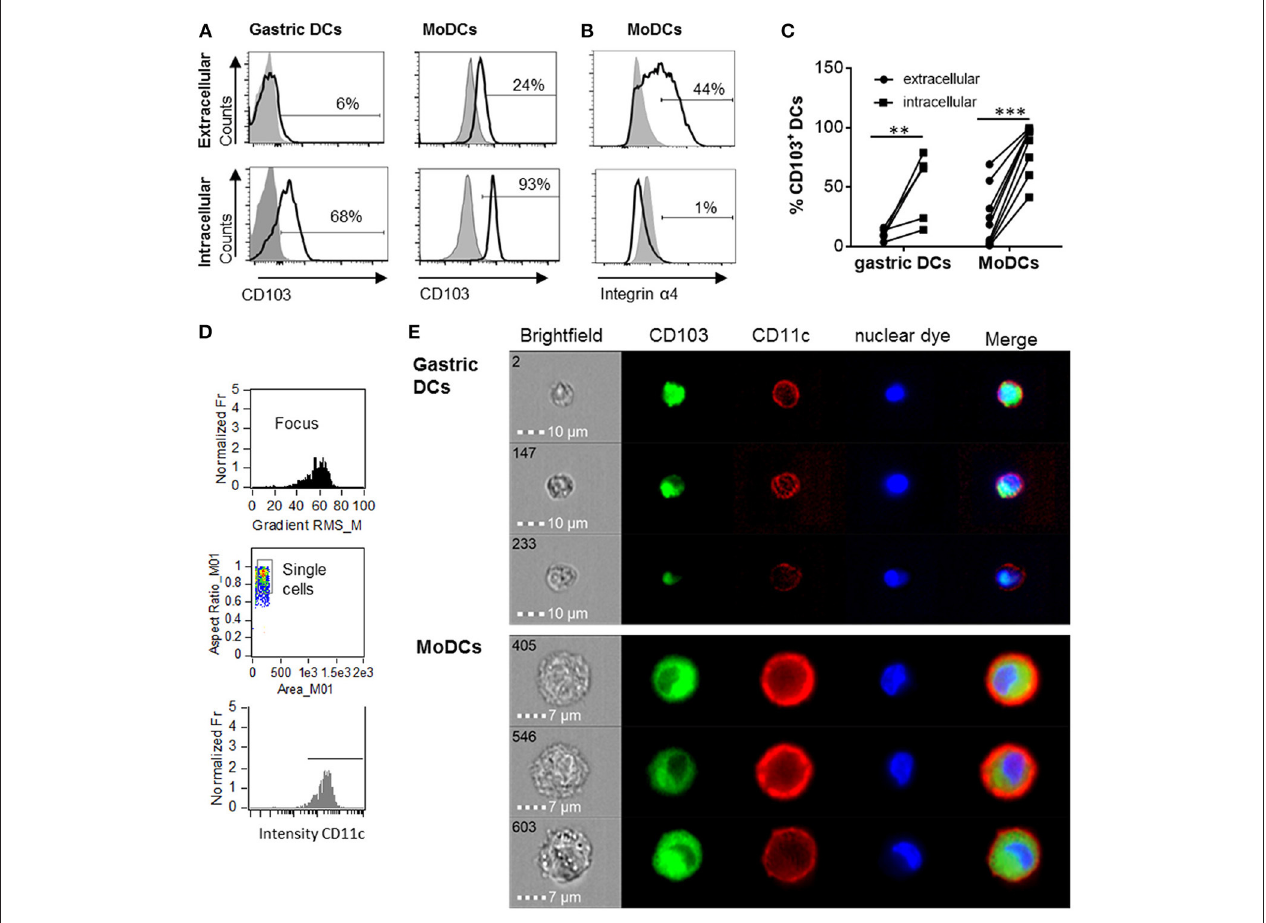
FIGURE 2 | Human gastric and MoDCs contain intracellular CD103 pools. Human gastric DCs gated as live/HLA-DR high /CD45 pos /lineage neg cells or MoDCs were labeled with (A) an anti-CD103 antibody or (B) an anti- α 4 integrin antibody using extracellular or intracellular staining protocols. (A,B) representative histograms and (C) individual values from 4 (gastric DCs) or 9 (MoDCs) independent experiments. ** P ≤ 0.01, *** P ≤ 0.001, ANOVA with Tukey’s post-hoc test. (D) Gating strategy for ImageStream imaging cytometry to select for focused, single cells with high CD11c expression. (E) Representative images from three independent imaging cytometry experiments show intracellular CD103 in CD11c + gastric DCs and MoDCs, 40 × objective. BF, bright field; nuclear dye, 7-AAD.